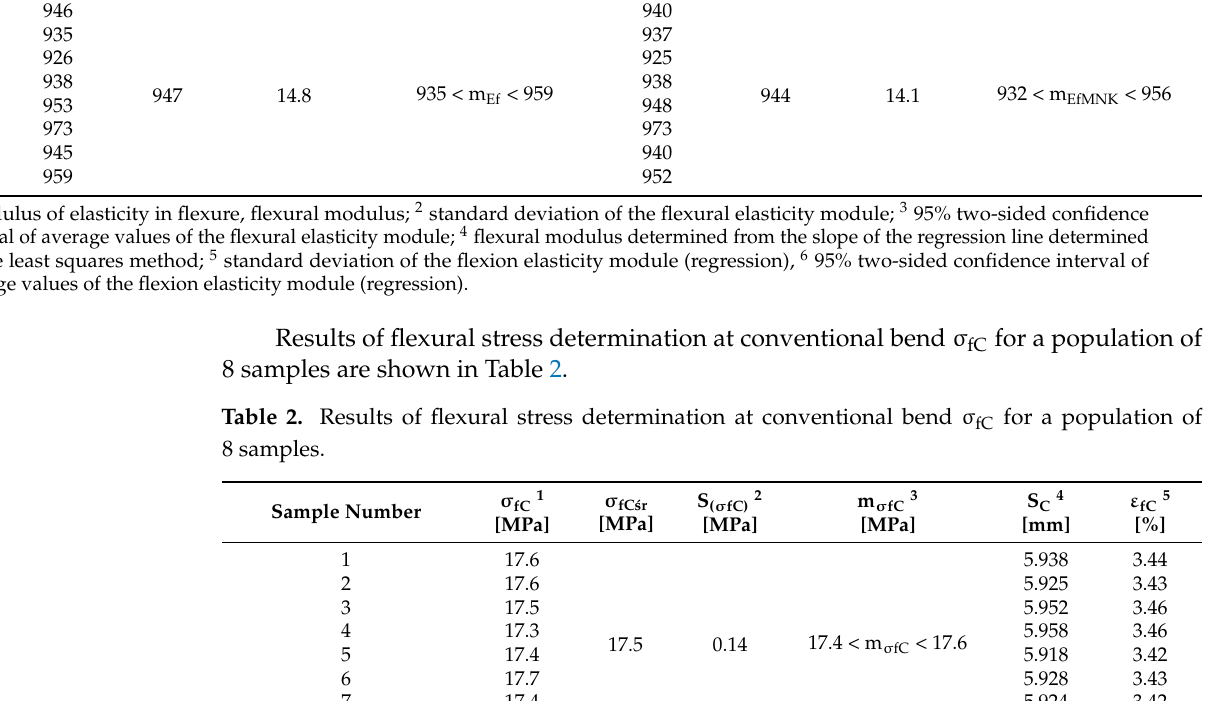
Table 1. Results of determination of the elasticity module at flexural E f for a population of 8 samples. Sample Number